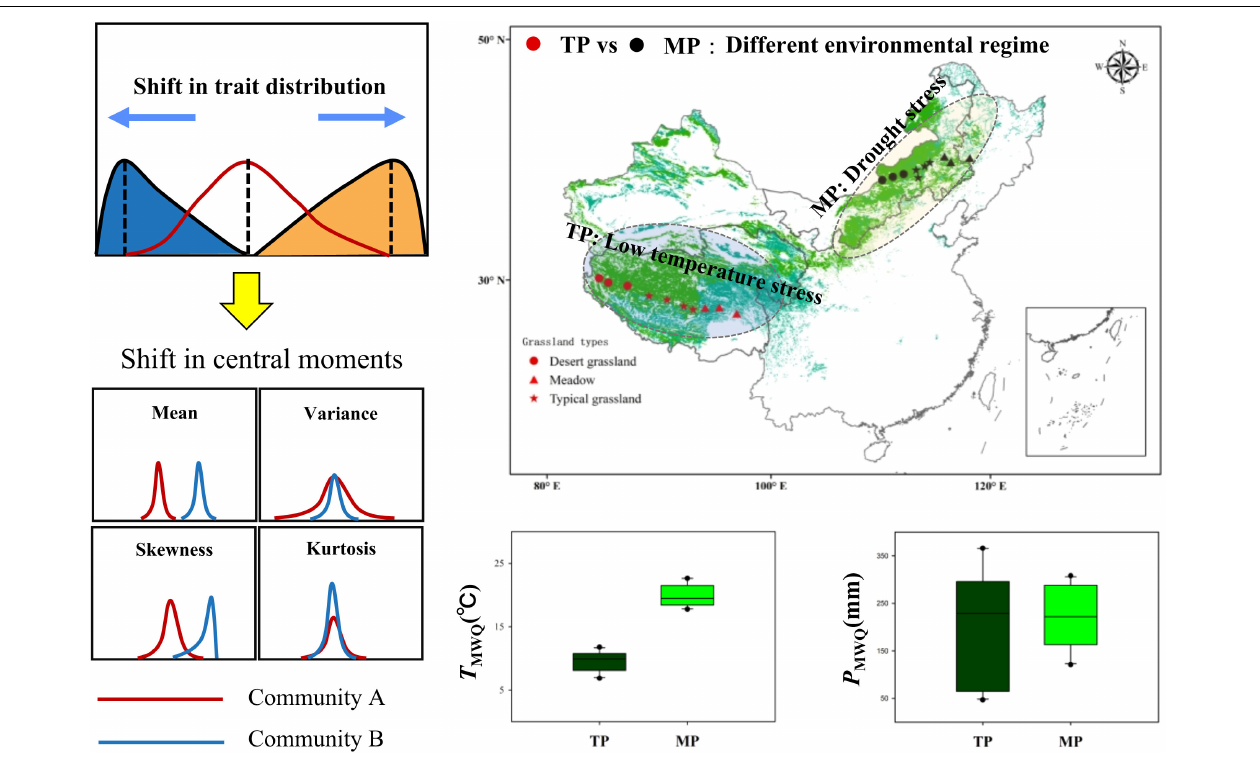
FIGURE 1 | Two comparative grassland transects on the Tibetan Plateau (TP) and the Mongolian Plateau (MP). They represent different environmental regimes. Each transect covers meadows, typical grasslands, and desert grasslands. The shifts in central moments of trait distribution represent the difference in intrinsic structure between two